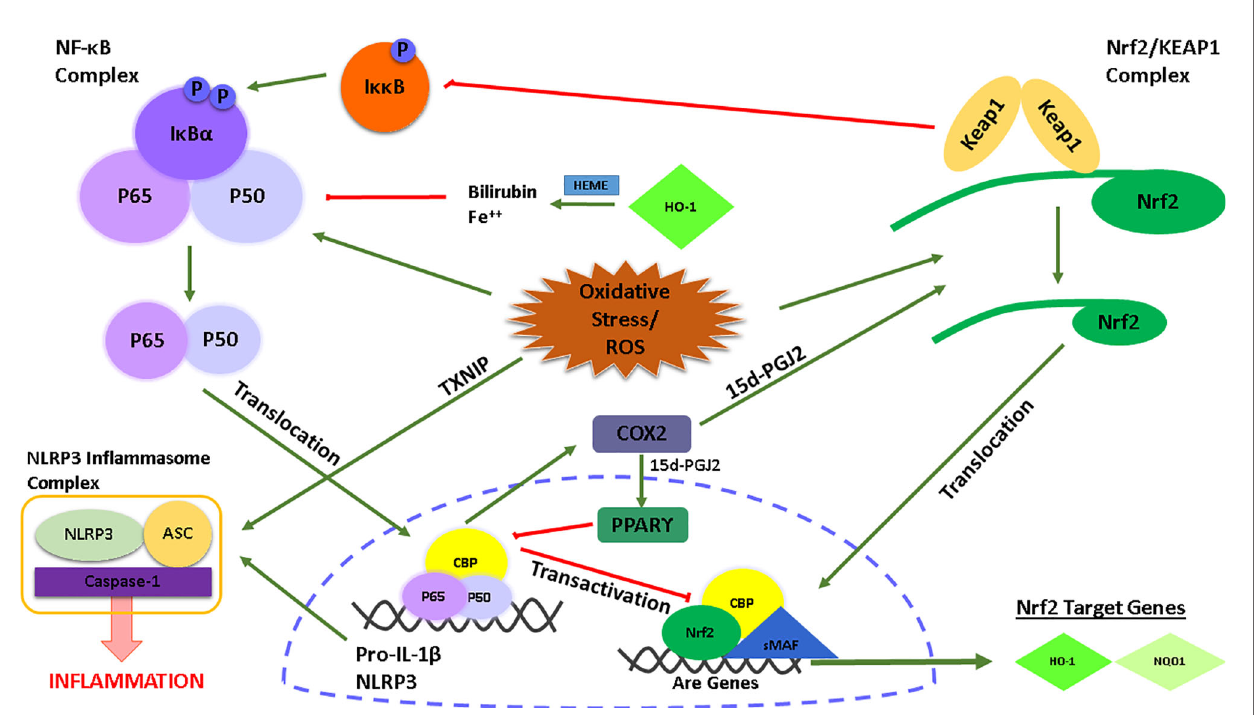
FIGURE 1 | Graphical illustration of the interconnection between the NLRP3/NF- k B signaling and the Nrf2 signaling